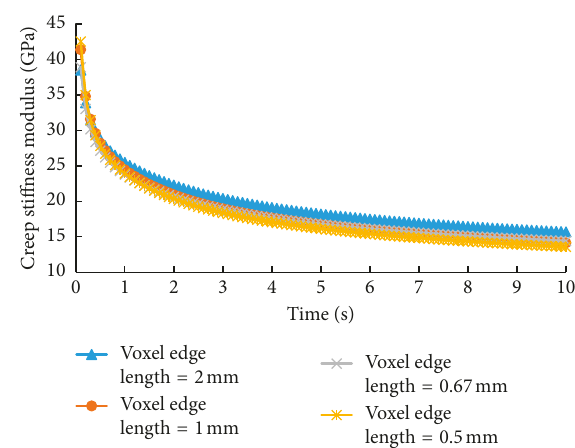
Figure 9: Creep stiffness modulus for four kinds of numerical